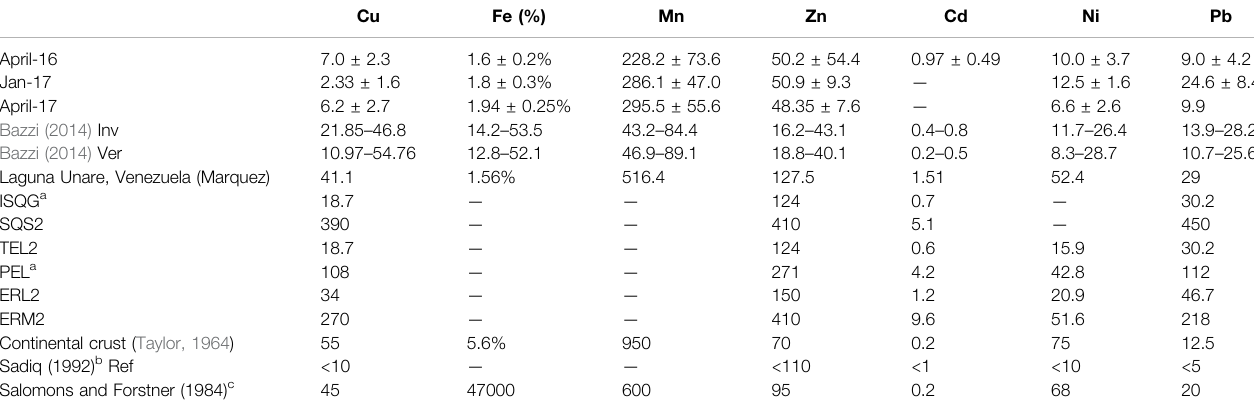
TABLE 3 | Enrichment factor and the geoaccumulation index of trace metals in sediment samples of the Navachiste coastal lagoon system, Mexico. Cu Fe (%)